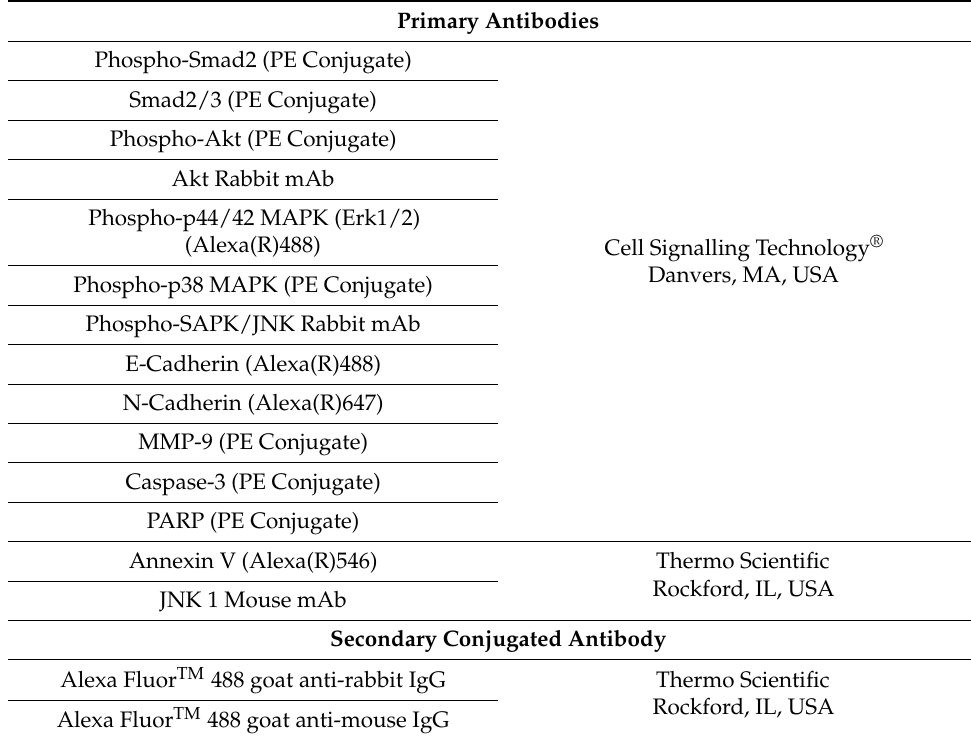
Table 3. Antibodies Used for Flow Cytometry